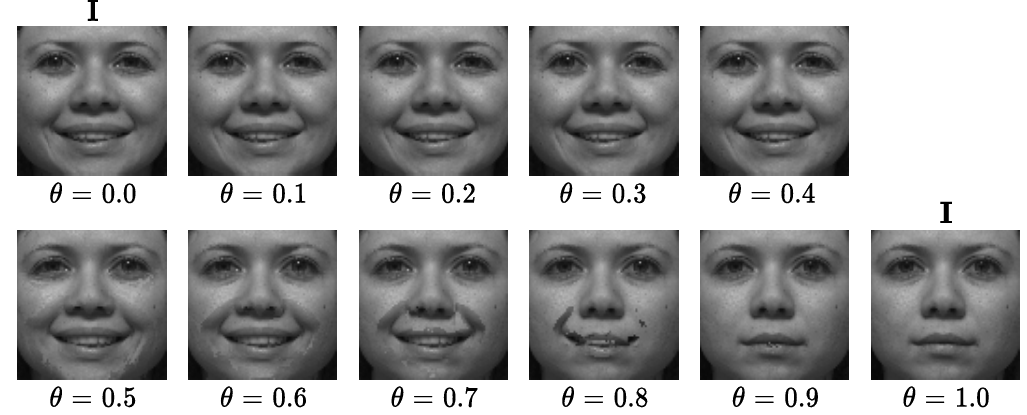
Figure 5. Generated images from I and ˆ I for each threshold ( θ